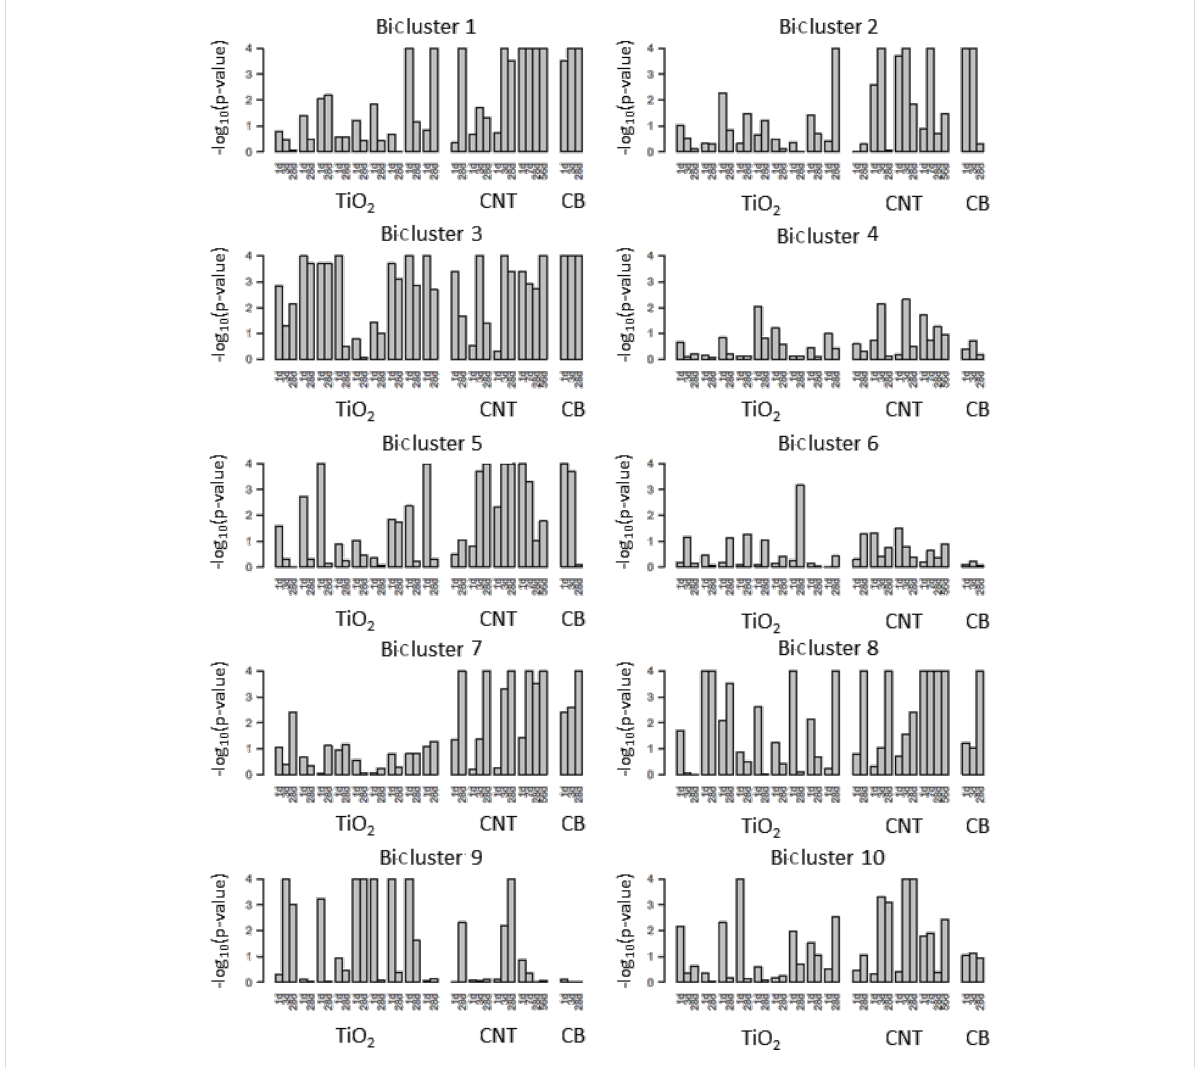
Figure 2: Gene set enrichment results of the NM datasets. Barplots of the − log 10 (p-value) from the GSEA are presented for each of the NM studies. The studies are ordered in the barplots as follows: TiO 2 : UV-Titan L181, NRCWE-025, NRCWE-030, Sanding Dust Indoor-R, Sanding Dust Indoor- nano, Sanding dust NRCWE-032, Sanding dust NRCWE-03, NRCWE 001 (No charge), NRCWE 002 (positively charged); CNT: Mitsui7, NRCWE-26, NM-401, MWCNT-7; CB: Printex